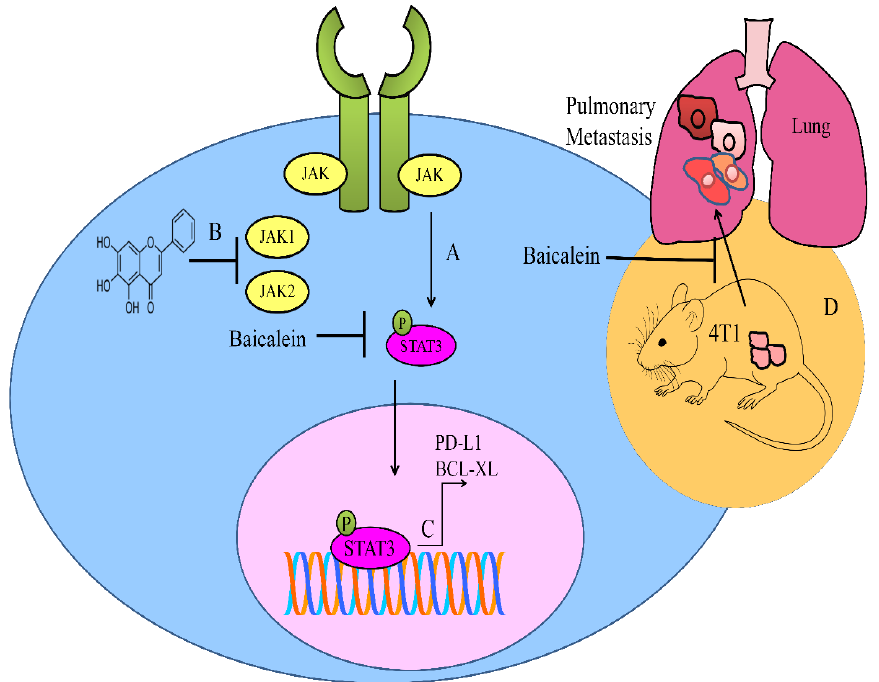
Figure 3. (A–C) Diagrammatic representation of JAK/STAT pathway. STAT3 upregulated PD-L1 and BCL-XL. Baicalein inactivated JAK/STAT pathway. (D) Baicalein inhibited pulmonary metastasis of breast cancer cells in animal model.